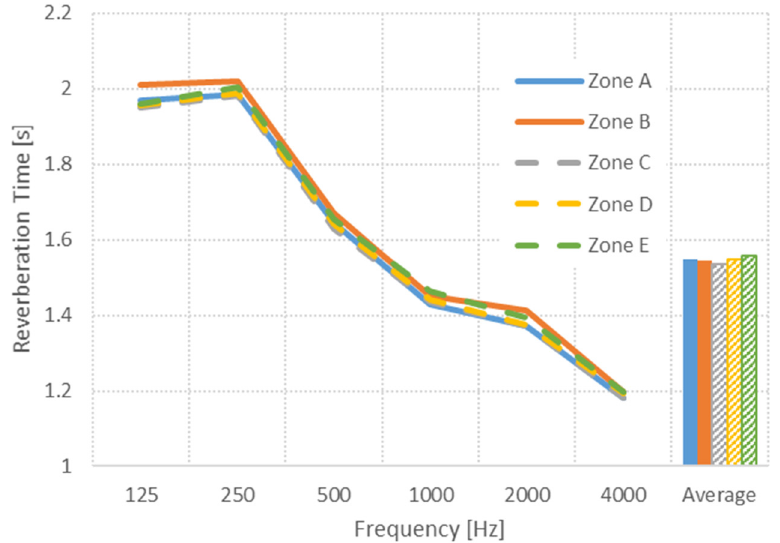
Figure 13. Reverberation time obtained in the auditorium, when the variable acoustic solution provides minimum absorption (configuration R), by zones.